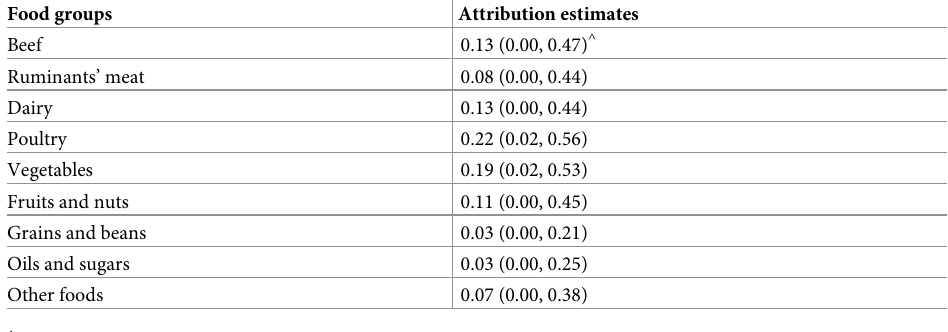
For Rwanda, most of the burden of dairy for all pathogens was attributed to cattle milk (~90 percent, Table 8). Note that the burden of M . bovis was attributed 100% to dairy by the study team as this pathogen is considered to be exclusively transmitted through milk [3,5]. The attribution to raw milk varied by pathogen with the highest proportions attributed for Brucella and Cryptosporidium (61% and 63%, respectively) and the lowest for Campylobacter (0.33). A substantial proportion of the burden from dairy was also attributed to traditionally fermented cattle milk products (~ 20%, Table 8) and even industrially fermented products (0.06–0.20). More detailed data including those used to create figures are provided in S2 Table. Table 6. Attribution of foodborne disease due to enterotoxigenic Escherichia coli in Burkina Faso to FERG food